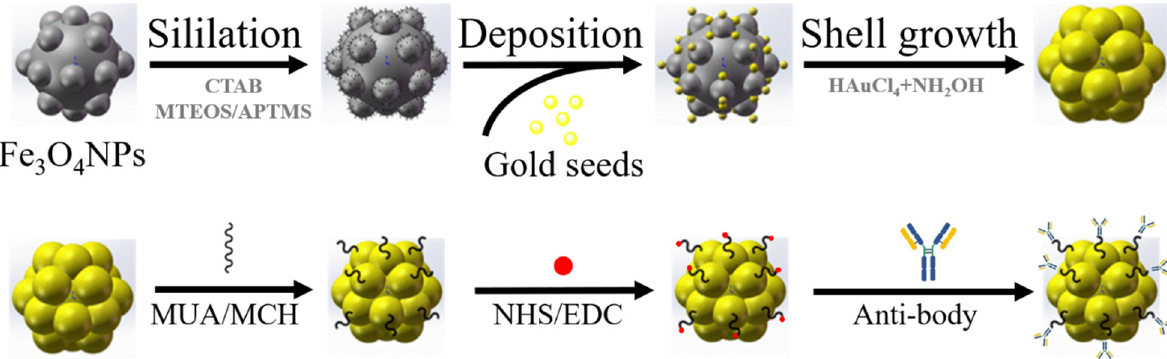
Figure 2. Synthesization and modification process of immunomagnetic beads. The synthesization was based on gold seed growth and sodium citrate reduction methods, and the modification was based on layer-by-layer self-assembly.